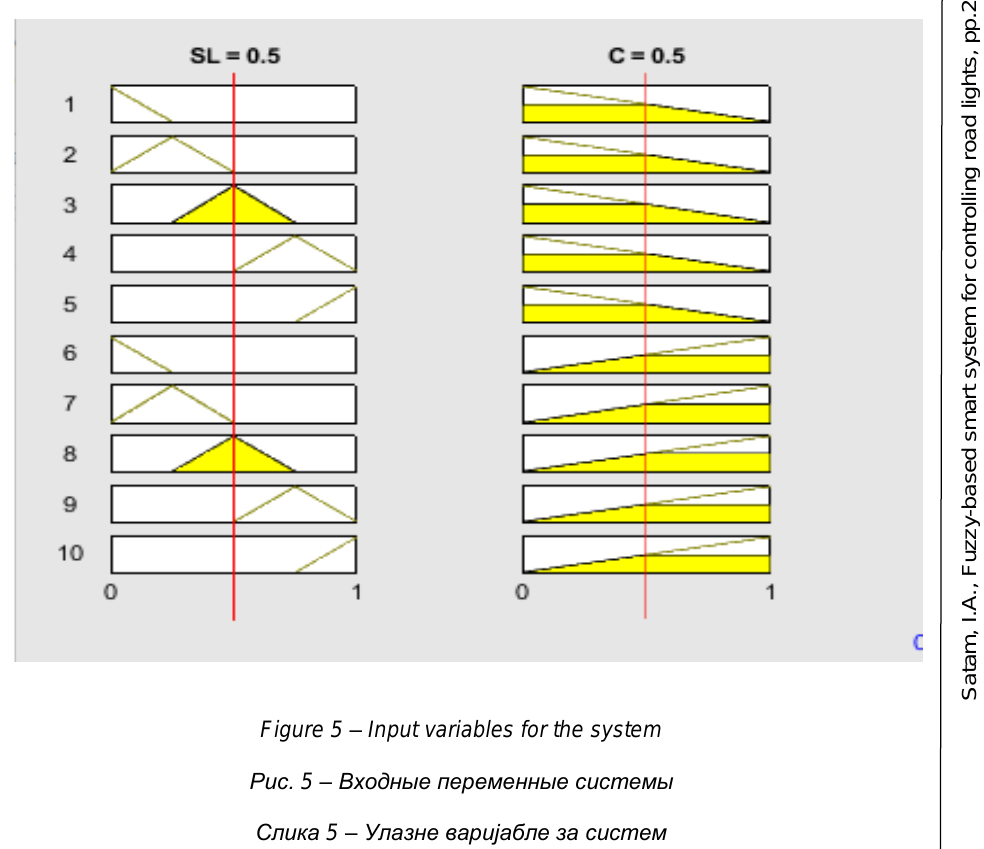
Figure 5 – Input variables for the system Рис. 5 – Входные переменные системы Слика 5 – Улазне варијабле за